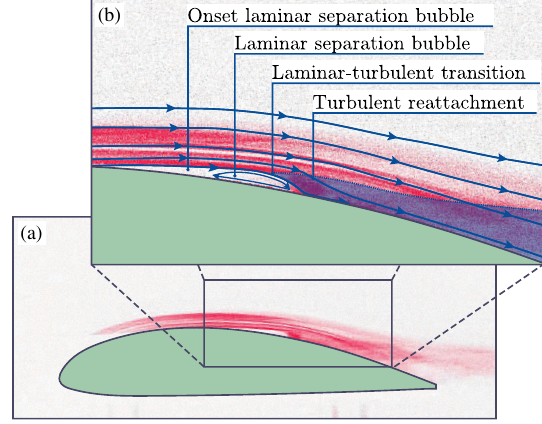
FIG. 2. Experimental setup consisting of (a) a HSPIV system and (b) a CK220 airfoil. A laminar inflow of u ∞ ¼ 11 m = s approaches the airfoil from the left-hand side, forming a LSB on the suction side. The light sheet (in green) is adjusted (c) tangen- tially to the surface approximately at the location where the LSB is observed. The coordinate system has its origin at the midspan leading edge and defines the main flow direction as the x direction, the spanwise direction as the y direction, and the normal to wind tunnel wall as the z direction. The chord length and span of the airfoil are denoted c and s , respectively.